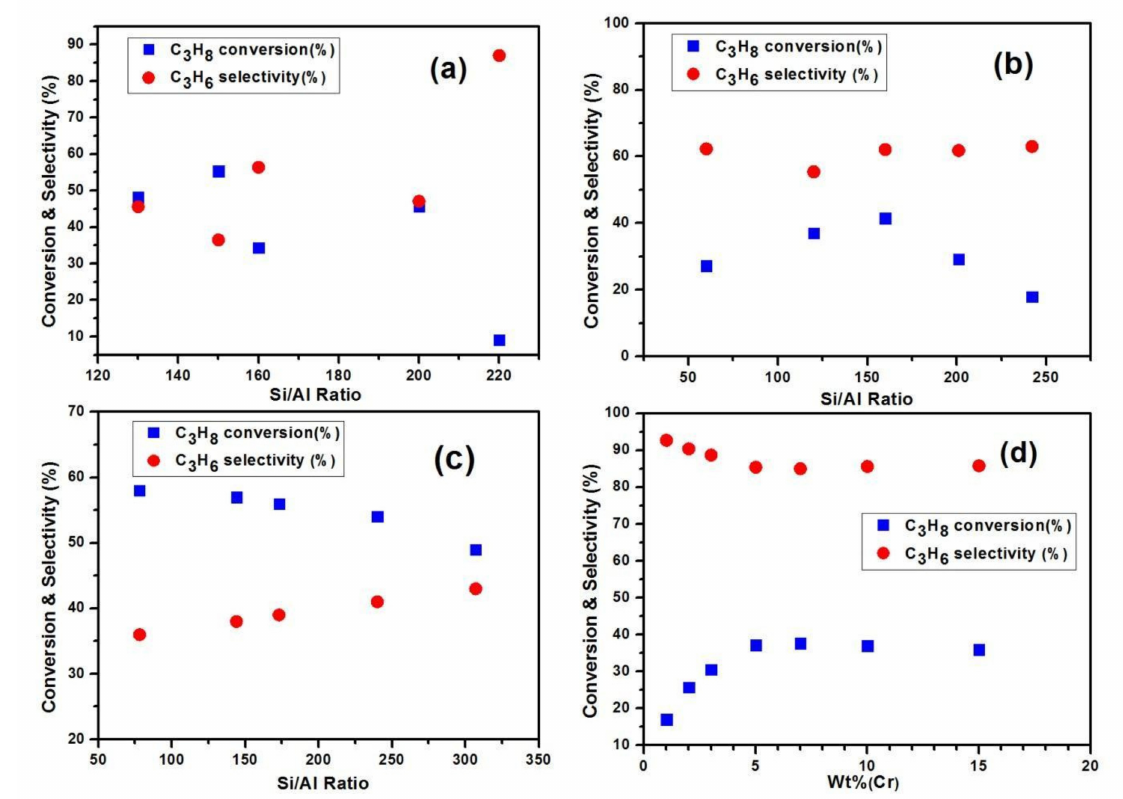
Figure 7. Influence of Si / Al proportion on the e ffi ciency of ( a ) Ga 2 O 3 / ZSM-48 zeolites (Reproduced from [118]; copyright (2012), Elsevier), ( b ) ZnO-HZSM-5 zeolites in the oxidative dehydrogenation of propane along with CO 2 (Reproduced from [105]; copyright (2009), Elsevier), ( c ) Ga 2 O 3 / M-HZSM-5 zeolites in the absence of CO 2 (Reproduced from [118]; copyright (2012), Elsevier), ( d ) Influence of Cr substance on the e ff ectiveness of Cr / SBA-15 in the carriage of CO 2 (Reproduced from [128]; copyright (2012),